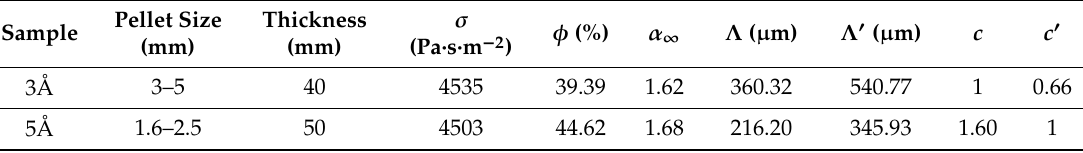
Table 4. Inverse non-acoustic parameters estimated by simulated